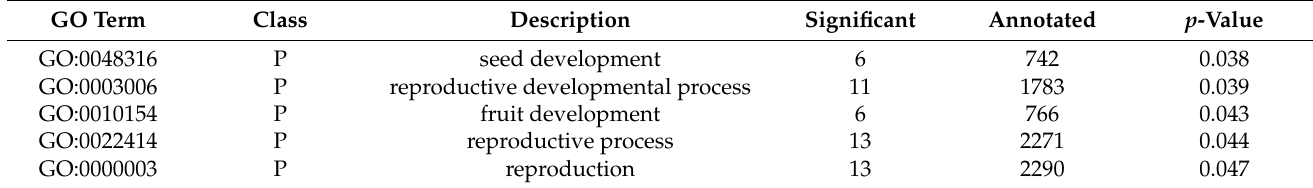
Table 2. The significantly over-represented GO terms of genes containing outlier SNPs in K. uniflora